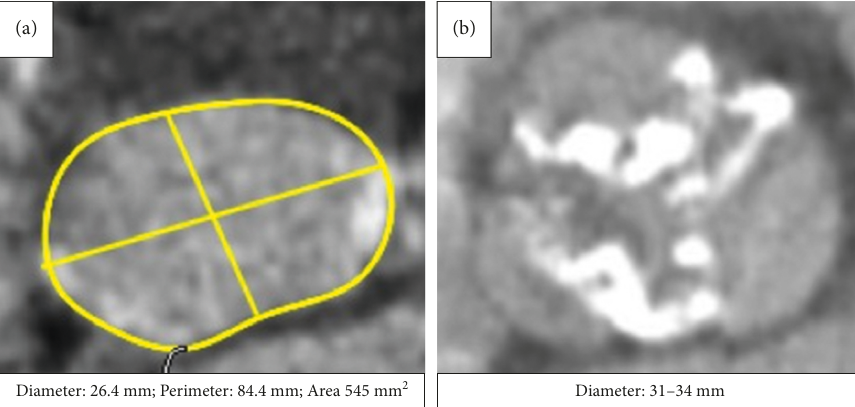
Figure 2: (a) MSCT of the aortic annulus with the diameter of 26.4mm, perimeter of 84.4mm, and aortic annular area of 542mm 2 . (b) MSCT of the aortic valve demonstrating a tricuspid aortic valve with heavy calcification of the aortic valve